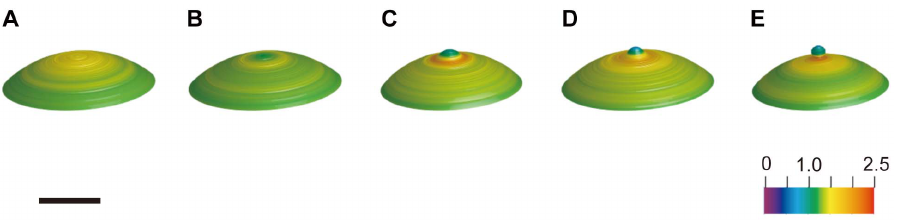
Figure 7. Time-course of actin distribution around the animal pole. Actin distribution (A) before and (B) at the onset of, and (C, D, E) after the bulge formation. Actin fluorescence distribution that had been analyzed previously [10] is shown in pseudocolor on the 3D cell surface whose image is restricted to the surface near the animal pole, at the height of 20 m m except for the bulge. For comparison with the data of the relative tension at the surface in Fig. 5, the fluorescence distribution is normalized by the ratio of actin fluorescent intensity around the animal pole to that at the surface at a vertical distance of 20 m m below the animal pole. A color scale indicating the normalized actin fluorescence from 0 to 2.5 is shown at the bottom right of the figure. Scal bar, 50 m m.